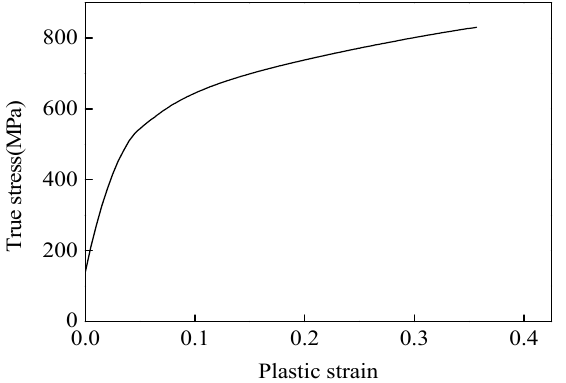
Figure 2. The true stress and plastic strain curve of TRIP 780.